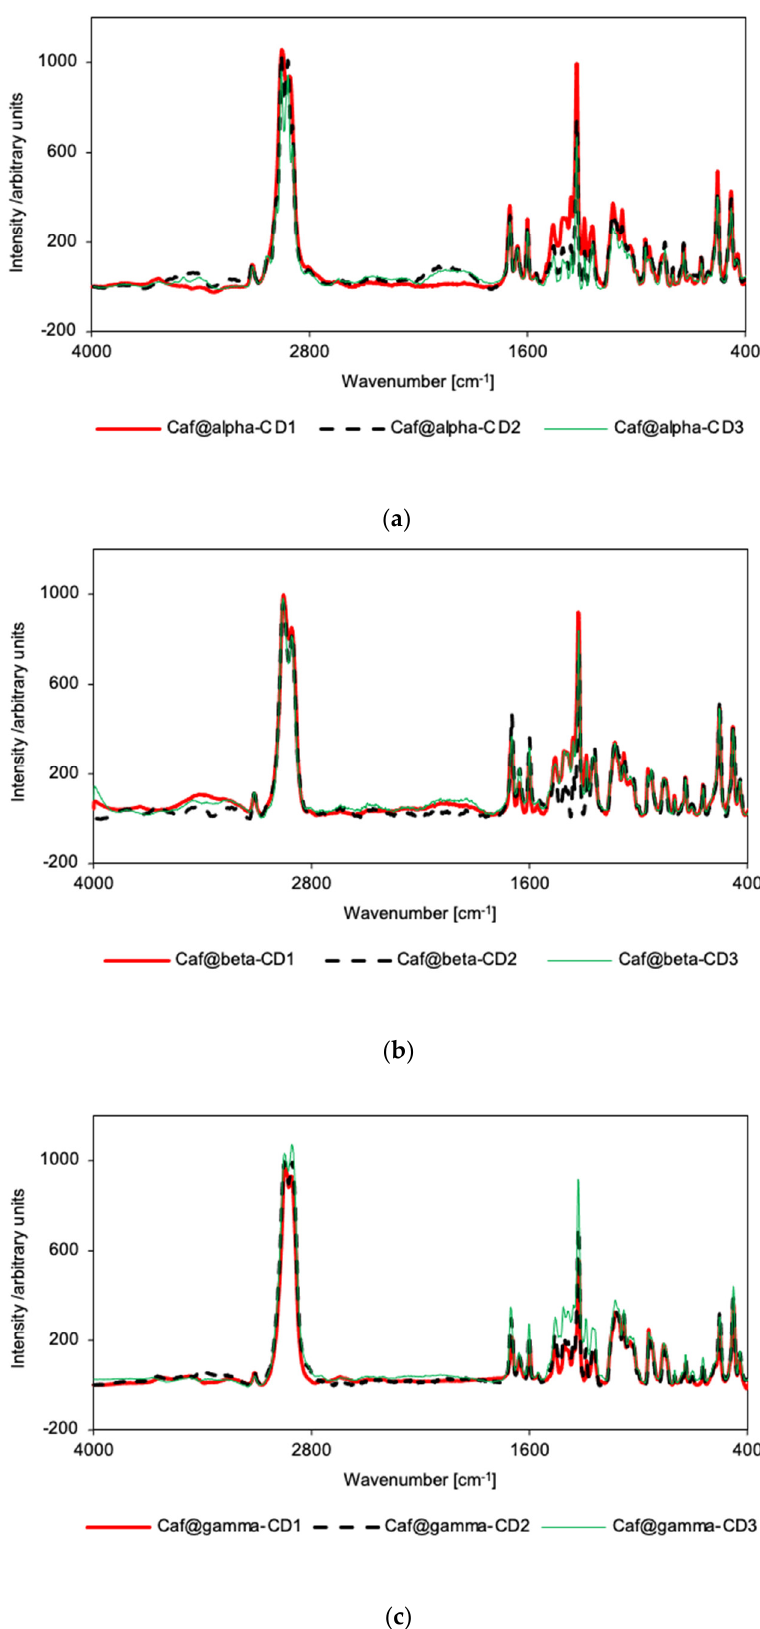
Figure 4. Raman spectra for Caf@CD obtained by three methods (1: cogrinding; 2: cogrinding with the addition of water drops; and 3: depositing from soln.). ( a ) α-CD; ( b ) β-CD; and ( c ) γ-CD series.